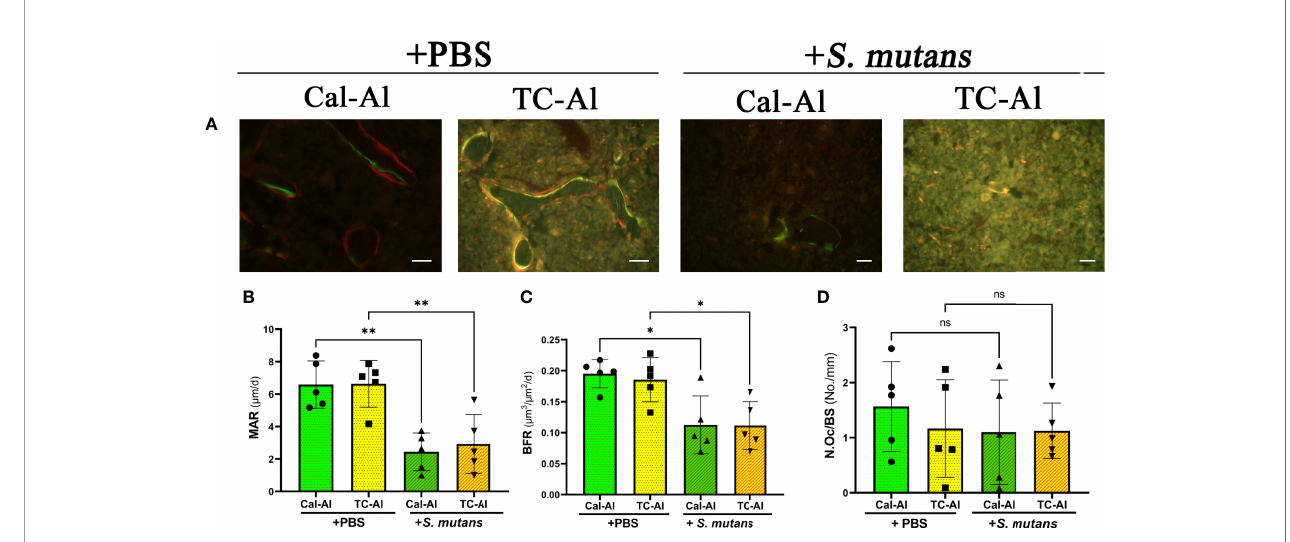
FIGURE 7 | S. mutans inoculation decreased structural bone formation parameters. Histological images and bone histomorphometry after seven days of intravenous injection of PBS or S. mutans inoculation. (A) Representative fl uorescence images of undecalci fi ed frozen sections: calcein (green), tetracycline (yellow), and alizarin (red). Scale bar = 50 m m. Quantitative analyses of bone formation activity were performed using standard bone histomorphometric measurement techniques based on the calcein/tetracycline- and alizarin-labeled surface in the ROI, which was described in the Materials and Methods section. (B) Mineral apposition rate (MAR), (C) Bone formation rate (BFR), (D) Number of osteoclast per bone surface (N.Oc/BS). Cal-Al, mice received double injections of calcein and alizarin; TC-Al, mice received double injections of tetracycline and alizarin; +PBS, intravenously PBS-injected groups; +S. mutans , intravenously S. mutans -inoculated groups. The variance of data was analyzed by the Levene test. The comparison between groups was analyzed by the ANOVA and Tukey HSD test. Values are expressed as the mean ± SD, *p < 0.05, **p < 0.01, ns, no signi fi cant